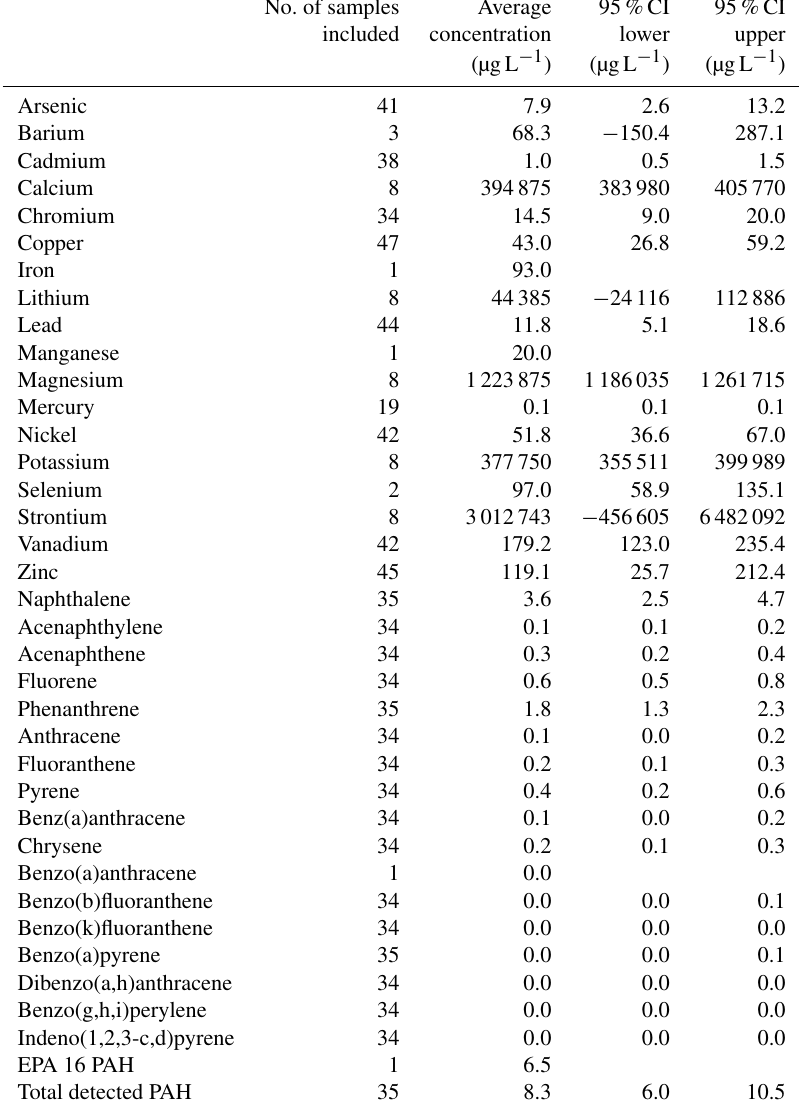
Table A2. Concentration of contaminants and nutrients in open-loop scrubber wash water. Note that full references to sample analysis reports are given in the